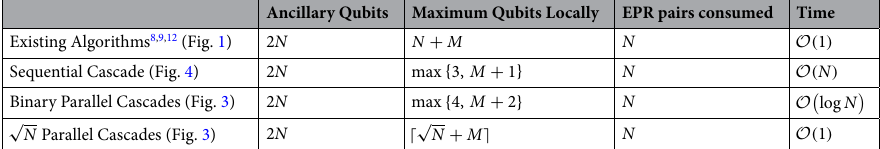
Ancillary Qubits Maximum Qubits Locally EPR pairs consumed Time M N O ( 1 ) + 3, M 1 { } +